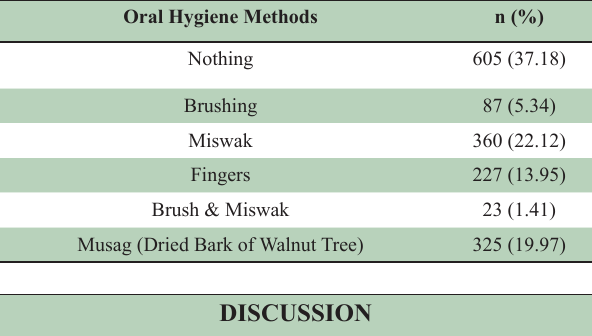
Table-III: Oral hygiene methods used by